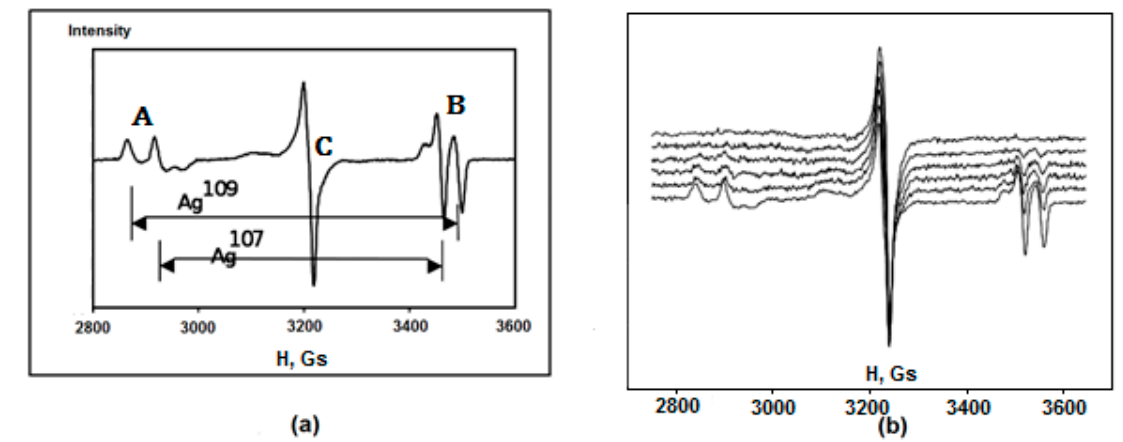
Figure 2. ESR spectra of silver—cyano-4 ′ -pentylbiphenyl co-condensate film ( a ) at 80 K and ( b ) at different temperatures of, from bottom to top, 80, 108, 120, 140, 150, 182, and 200 K.